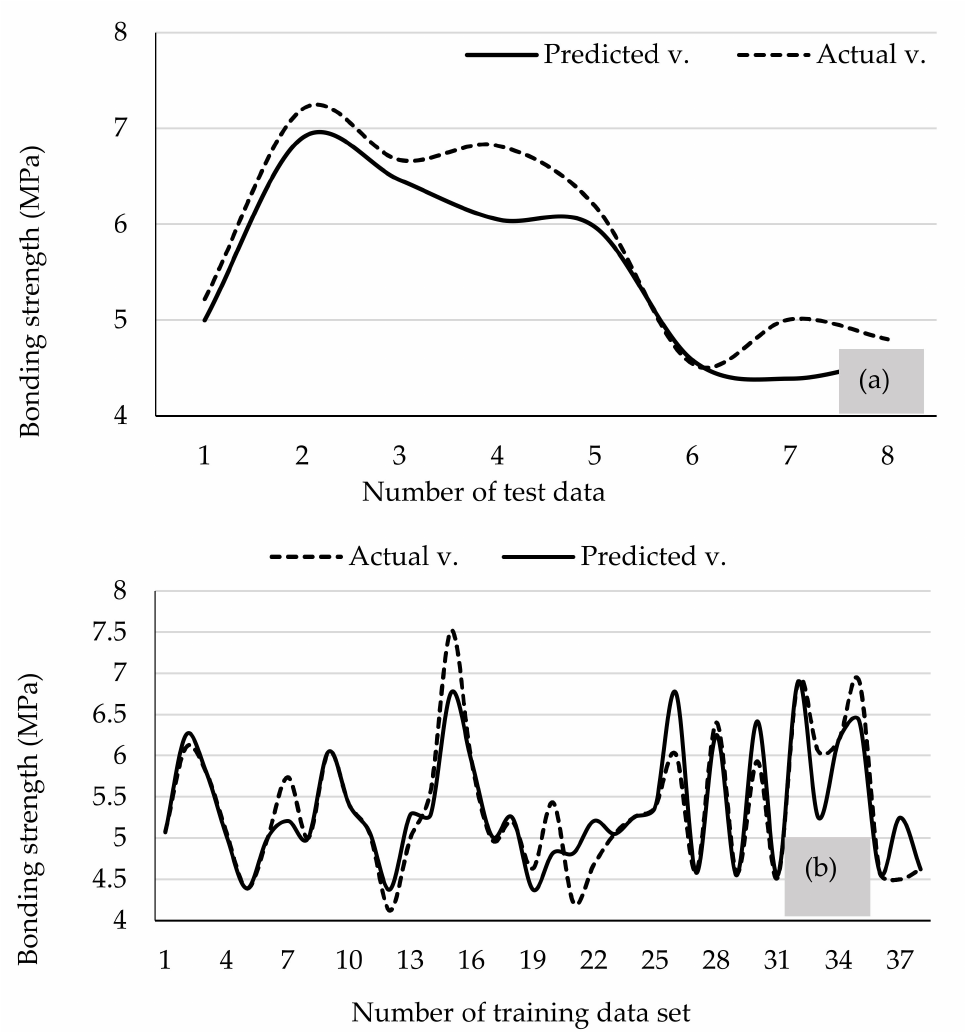
Figure 7. Comparison of the measured values and the values predicted by ANN for bonding strength: testing data set ( a ), training data set ( b